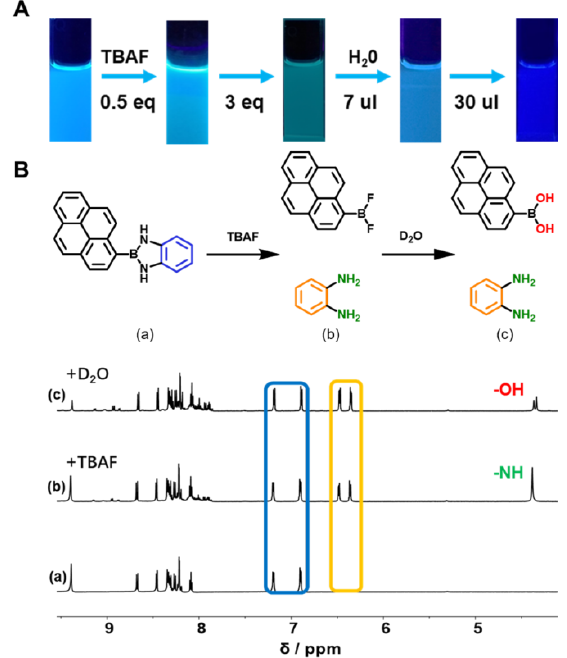
Figure 4. ( A ) Emission changes of Py-NBN-Ph solution after adding TBAF and water; ( B ) 1 H NMR spectra of Py-NBN-Ph in DMSO- d 6 ( a ), after the addition of 1.0 equal of TBAF ( b ), and followed by the addition of 15 μL of D 2 O ( c ).